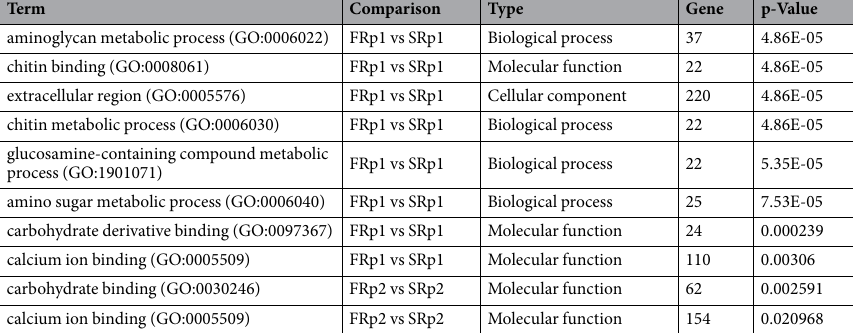
Table 3. GO classification of the differentially expressed genes from R. philippinarum .